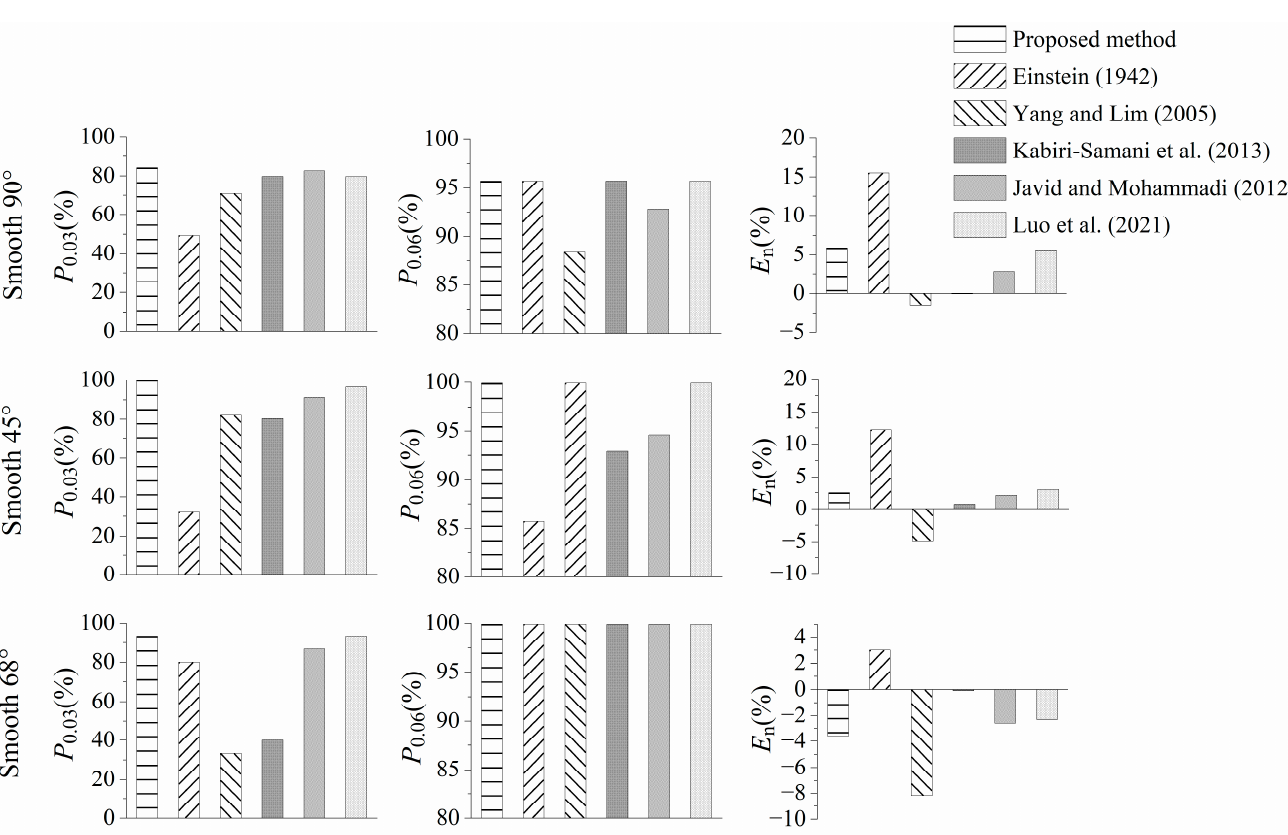
Figure 4. Performance of different methods for smooth boundary cases (Einstein 1942 [19],